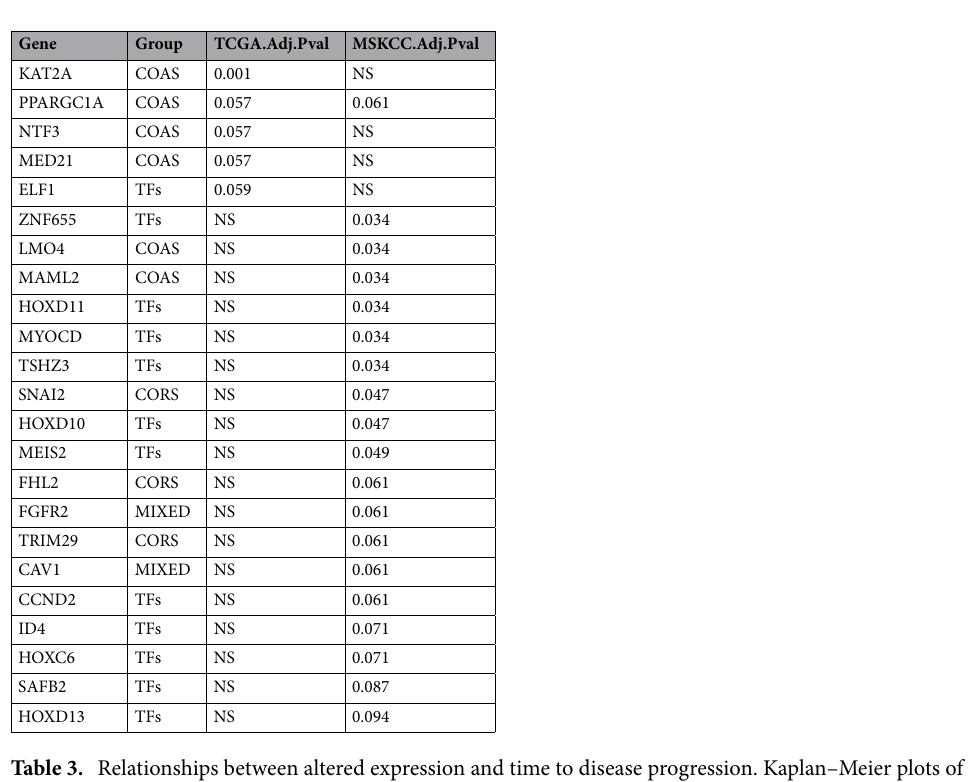
Table 3. Relationships between altered expression and time to disease progression. Kaplan–Meier plots of the relationship between tumors with lower and upper quartile expression of the indicated gene and time to biochemical progression were generated and the FDR-corrected p values